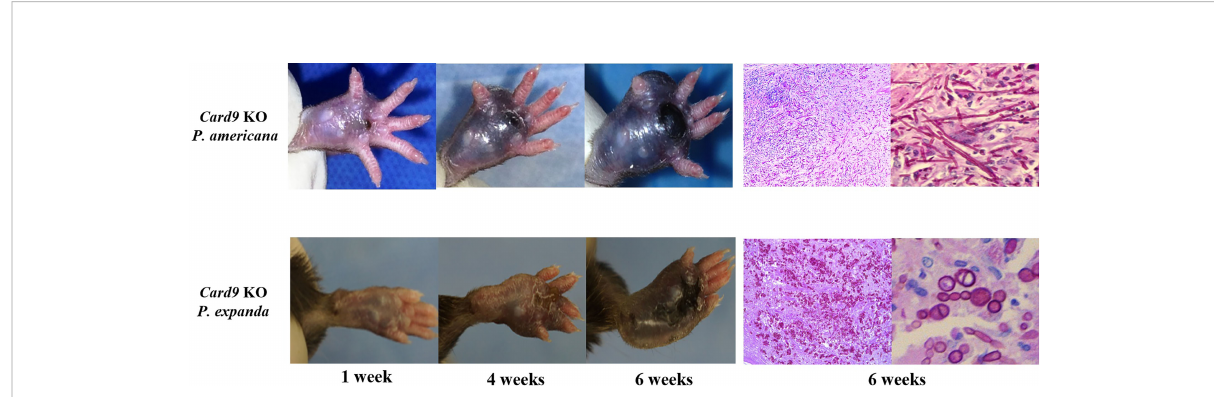
FIGURE 5 Murine model of subcutaneous dematiaceous fungal infections. Card9 KO mice were inoculated subcutaneously with 1×10 8 CFU of live P. expanda or P. americana spores. Representative images of infected footpads (1/4/6 weeks post-inoculation). Histopathology of PAS-stained footpad from infected Card9 KO mice at 6 weeks post-infection (original magni fi cation